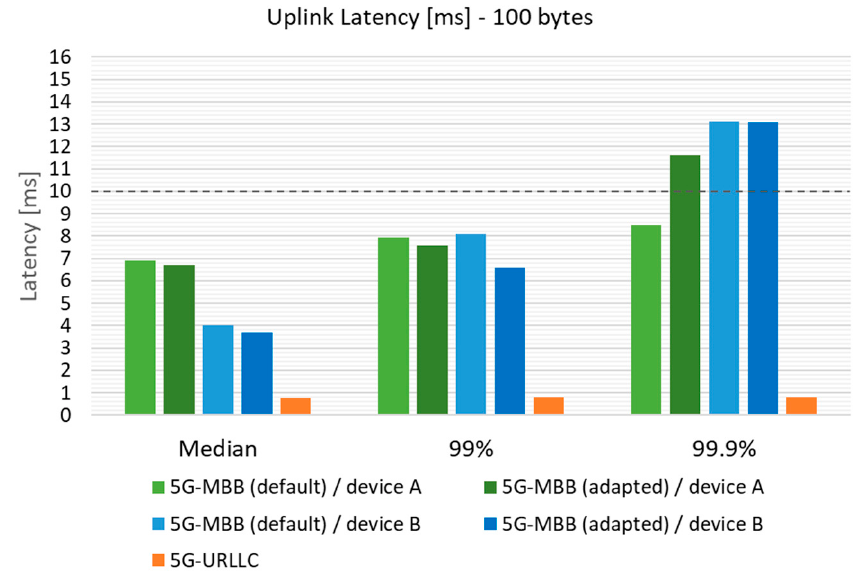
Figure 5. Uplink latency for 100-byte messages and different reliability percentiles (median, 99th percentile, 99.9th percentile).